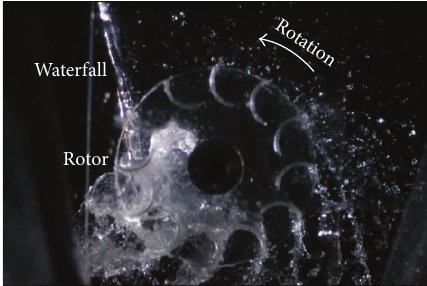
Figure 7: Experimentally visualized flow pattern when 𝜆 = 0.56 .